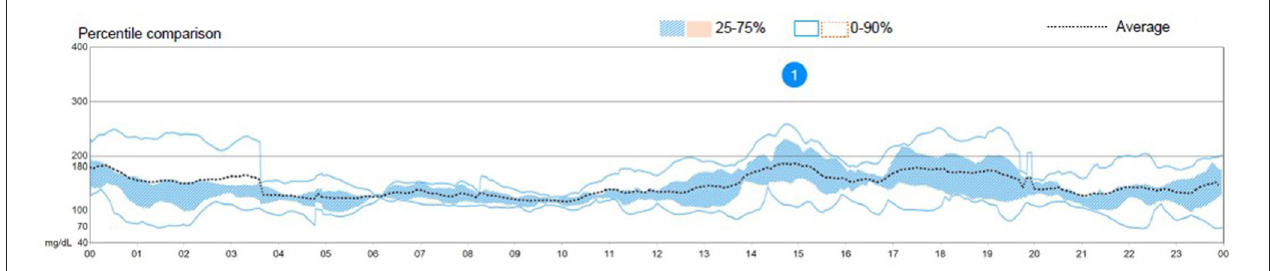
TABLE 1 | Summary of recommendations on the use of the hybrid closed-loop system during the perioperative period. Pre-surgery